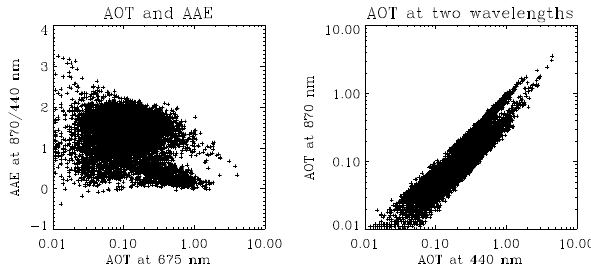
Fig. 11. Correlations among co-located observations for the R128E2P4 and R128E2P4 2AOT experiments. Unsurprisingly, strong correlations exist when using AOT at two wavelengths.